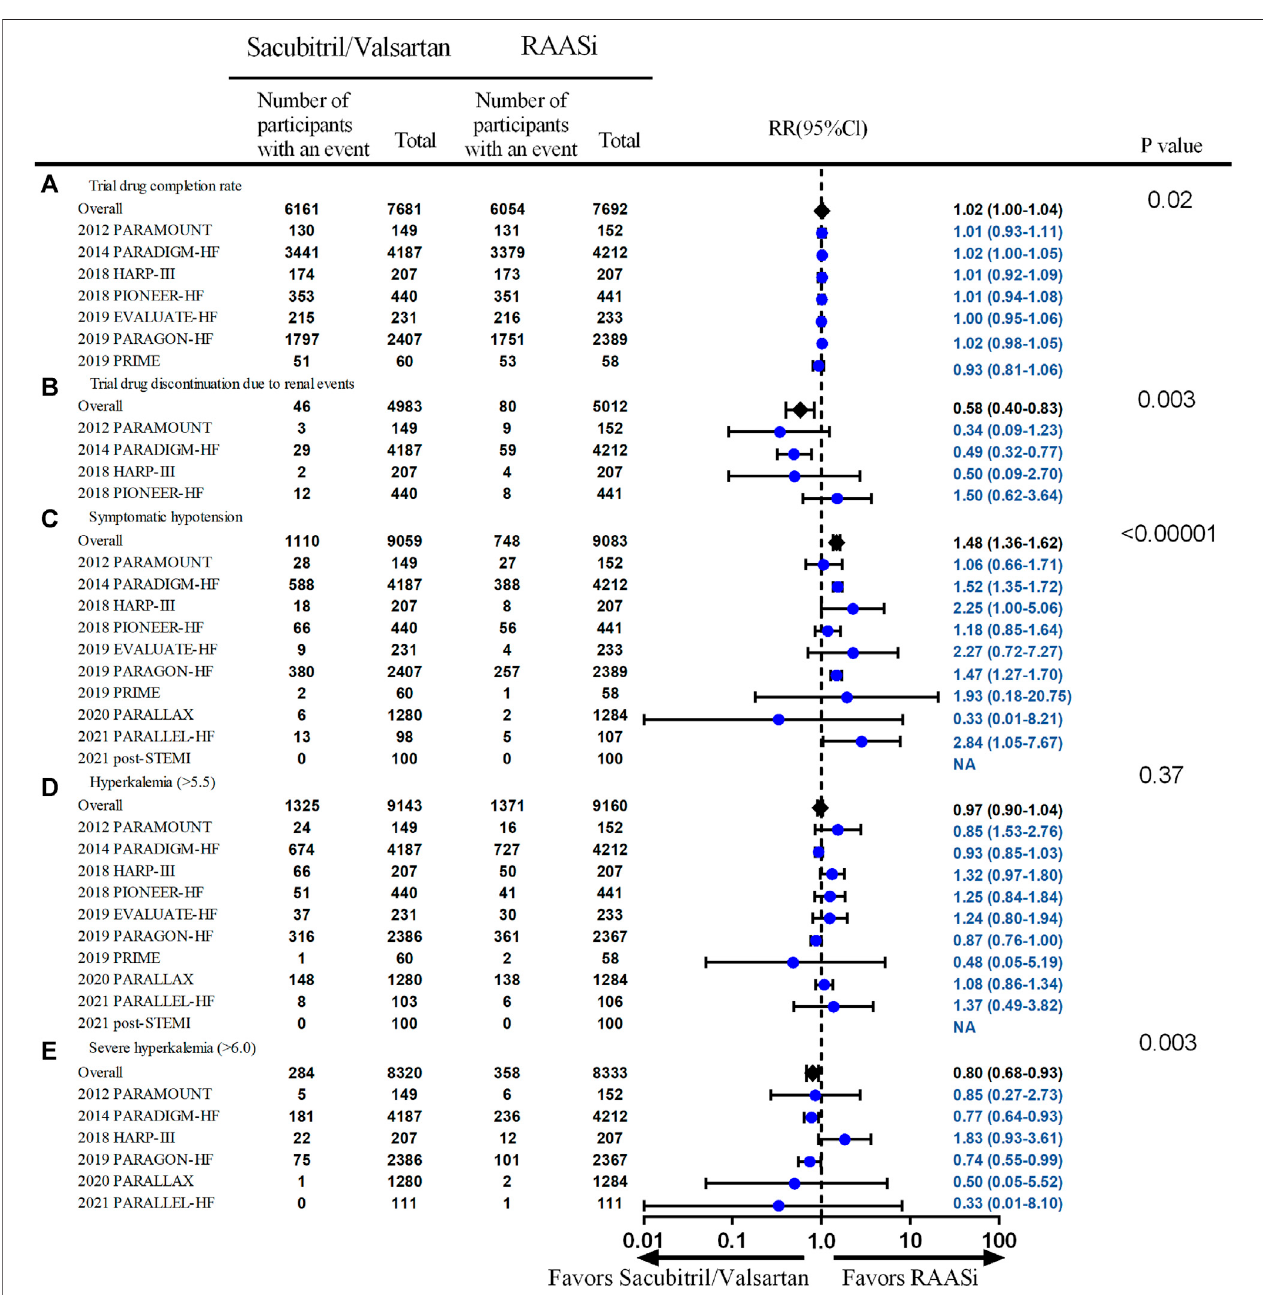
FIGURE 6 | Compliance and safety outcomes — outcomes of trial drug completion rate, trial drug discontinuation due to renal events, systematic hypotension, hyperkalemia, and severe hyperkalemia. Outcomes were from fi xed-effect meta-analysis. RAASi, renin – angiotensin – aldosterone system inhibitor; RR, relative ratio.